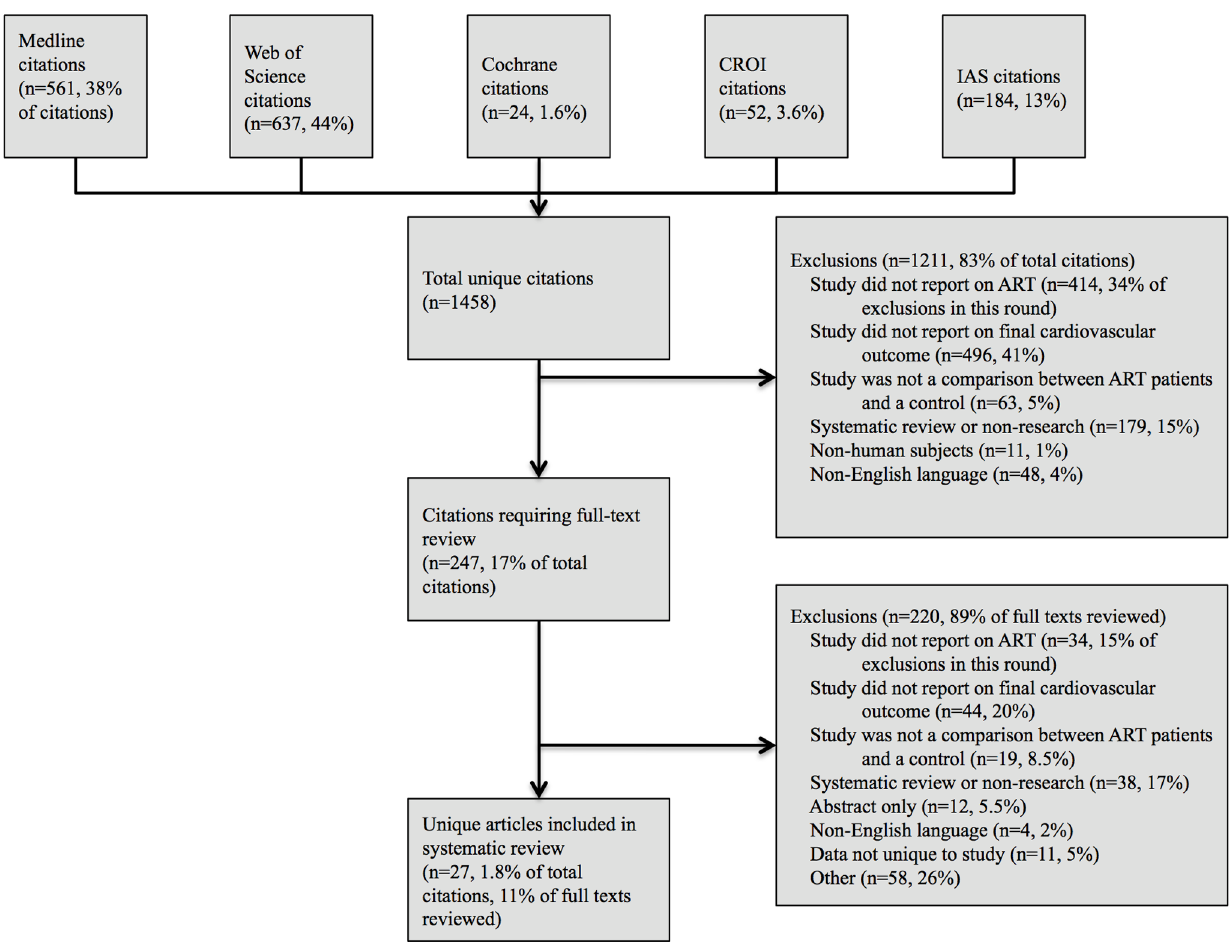
Figure 1. Study flow diagram.